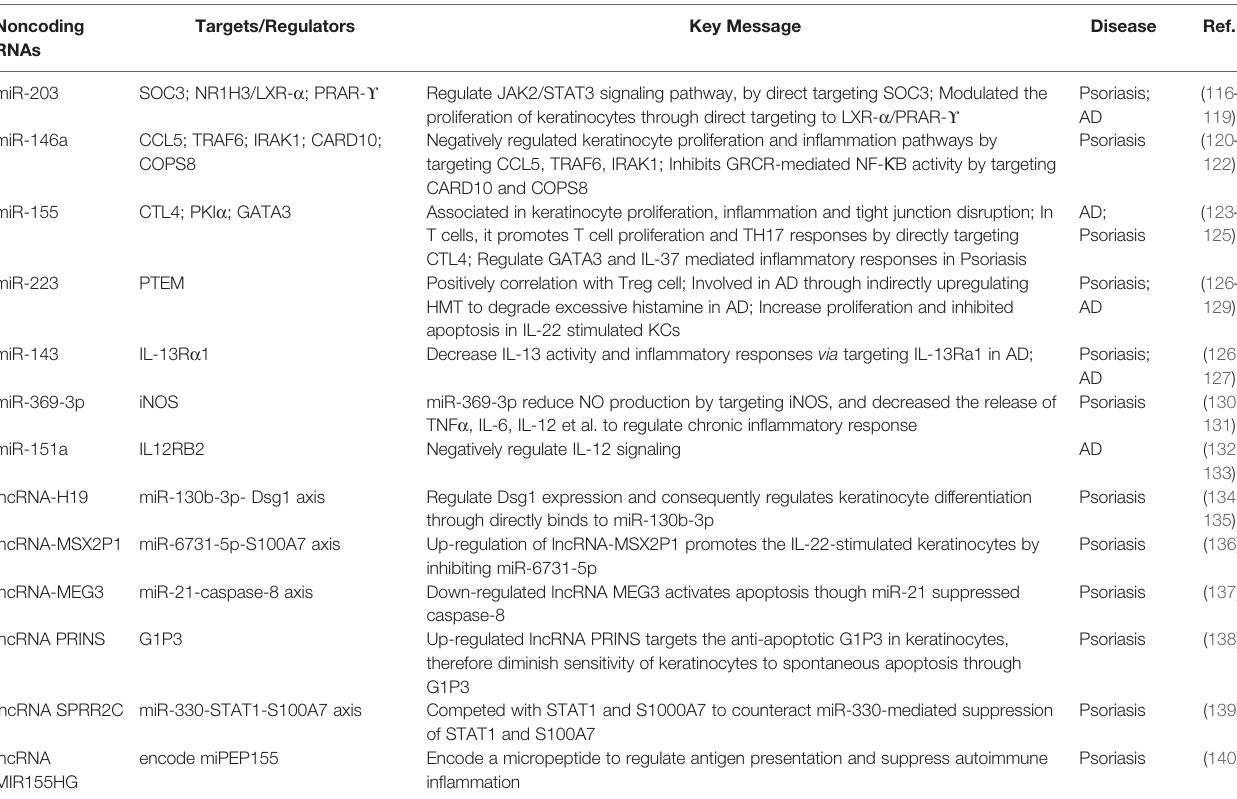
TABLE 2 | Noncoding RNAs in AD and